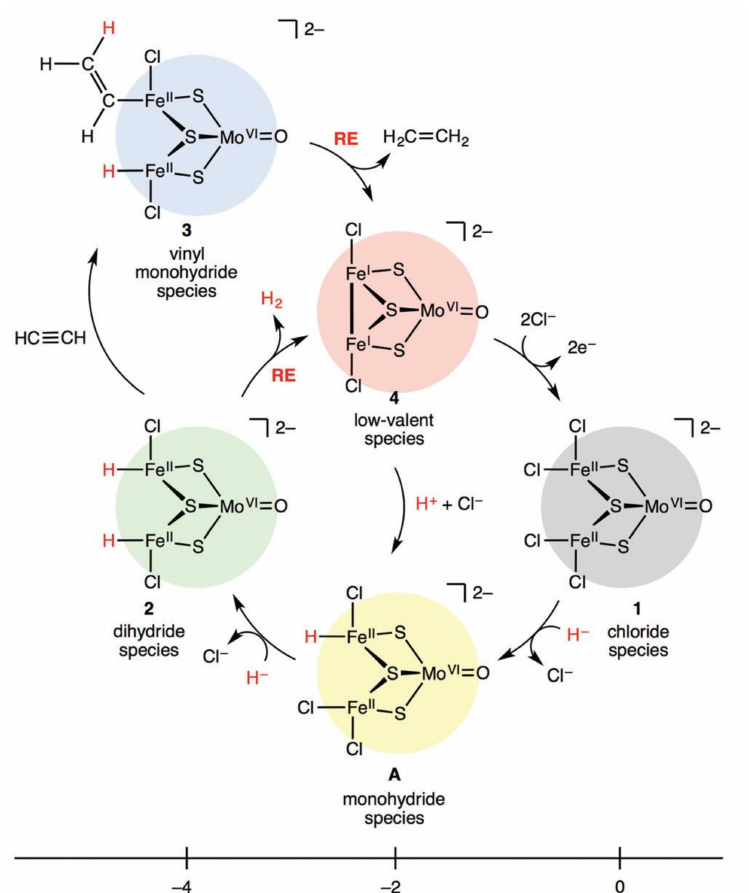
Figure 25. Proposed mechanism of reductive elimination (RE) of H 2 from the dihydride Fe/Mo species 2 and C 2 H 4 from the vinyl monohydride Fe/Mo species 3 . The scale of horizontal axis represents oxidation states 0 to –4, with the initial oxidation state of 1 corresponding to 0. Accordingly, the two and four electron-deprived species correspond to –2 and –4 oxidation states, respectively (reproduced with permission from [302]. Copyright 2016 the Royal Society of